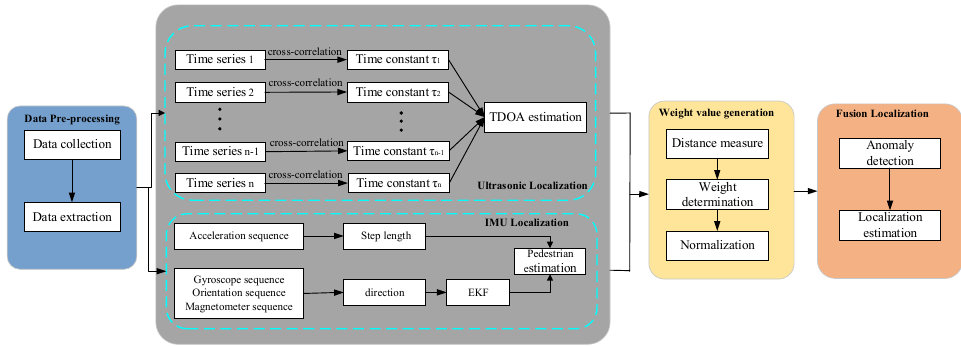
Figure 2. Detailed technical implementation of the proposed fuse localization system.